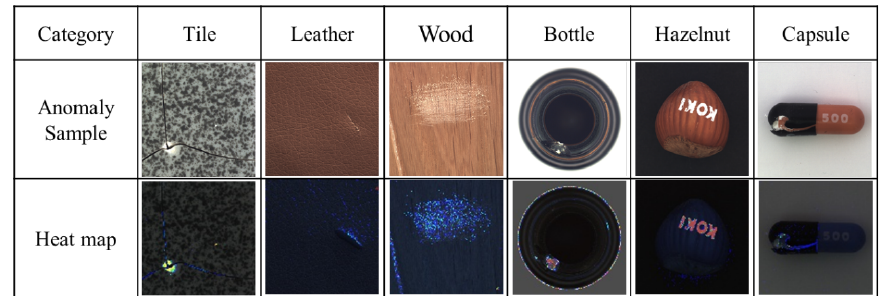
Figure 8. Heat maps of the MVTec AD dataset generated by the proposed method (DAGAN).